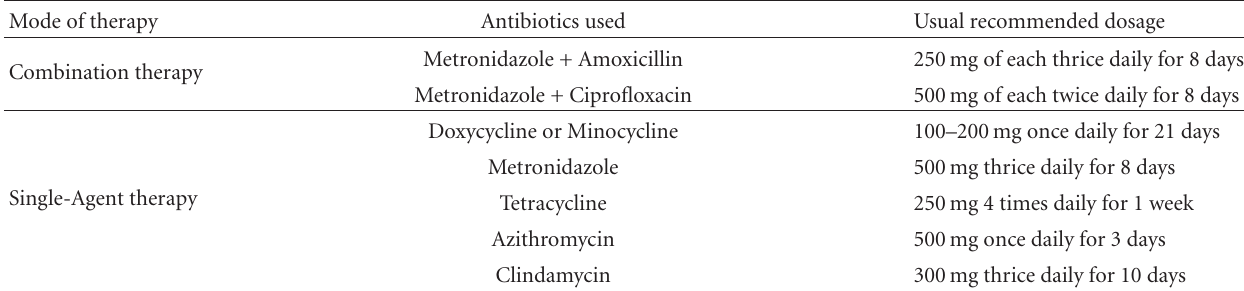
Table 1: The list of antibiotic regimens with evidence of superior clinical outcome when used as an adjuvant to SRP in GAgP [24, 45–57]. Mode of